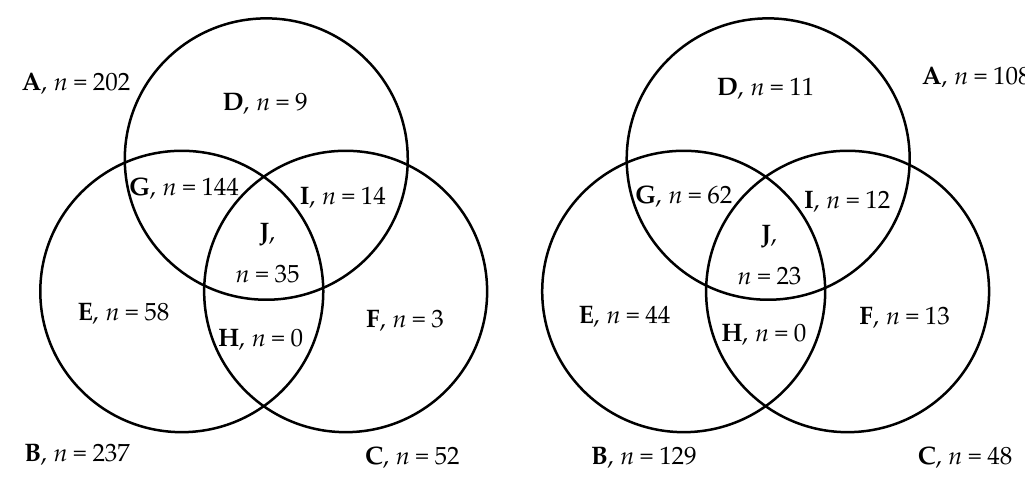
Figure 2. The nutritional status of study participants aged less than 61 months. Here, ( A ) indicates the total number of underweight children (A = D + G + I + J); ( B ) indicates the total number of stunted children (B = E + G + H + J); ( C ) indicates the total number of wasted children (C = F + H + I + J); ( D ) indicates the total number of children who were underweight only; ( E ) indicates the total number of children who were stunted only; ( F ) indicates the total number of children who were wasted only; ( G ) indicates the total number of children who were underweight and stunted but not wasted; ( H ) indicates the total number of children who were stunted and wasted but not underweight; ( I ) indicates the total number of children who were underweight and wasted but not stunted; ( J ) indicates the total number of children who were underweight, stunted and wasted.